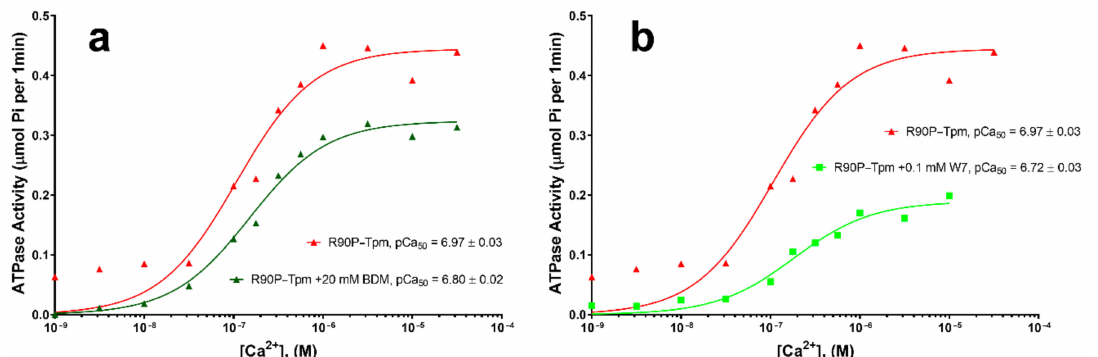
Figure 9. The effect of 20 mM BDM ( a ) and 100 µ M W7 ( b ) on the sensitivity of the thin filaments containing the R90P mutation in γ -Tpm to activating Ca 2+ concentrations. Ca 2+ -dependence is determined for fully regulated reconstituted thin filaments. The actin-S1 ATPase is measured in the presence of R90P-Tpm and 20 mM BDM or 0.1 mM W7 at 25 ◦ C. Each panel shows one of the typical graphs. pCa values are calculated from the data averaged from three experiments. Errors indicate ± SEM.